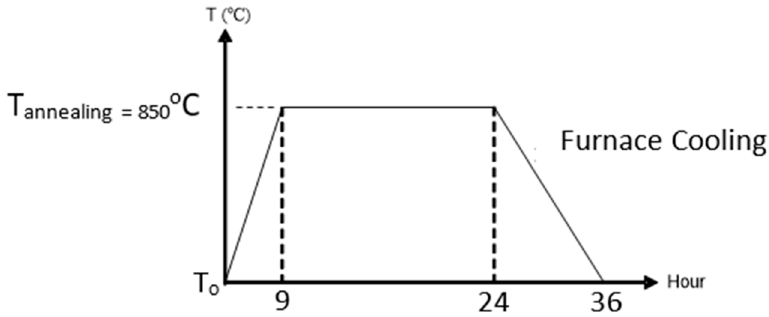
Figure 3. The annealing process.